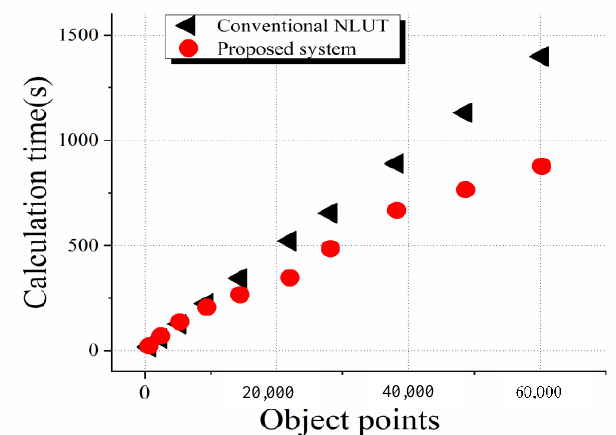
Figure 10. Relationship between the calculation time of the hologram and the object points by using different algorithms.